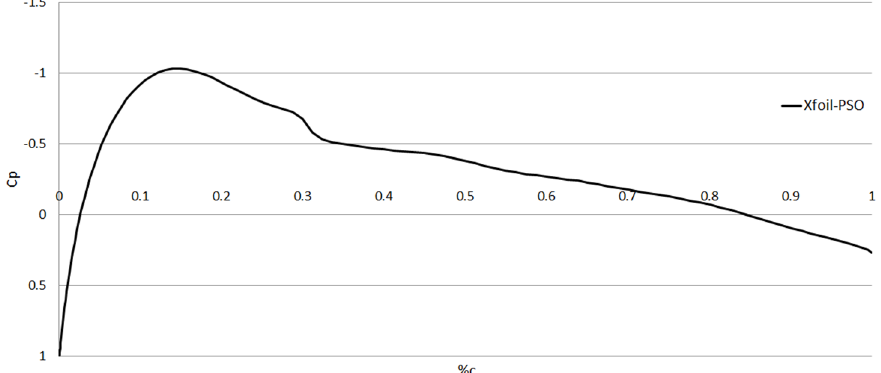
Figure 12. Pressure distribution (Cp) of the optimized airfoil PSO for AOA = 3 for a flow speed of 30.1 m/s.